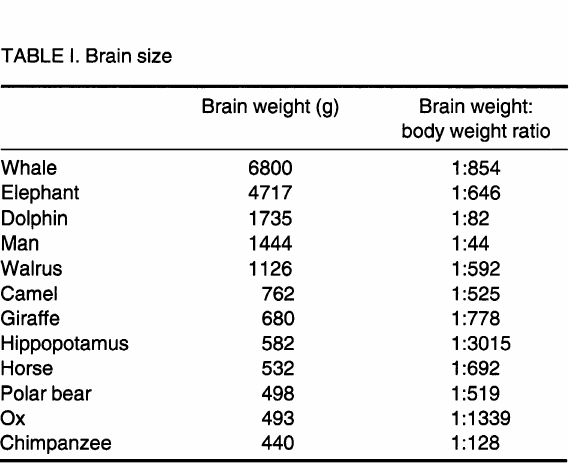
TABLE I. Brain size